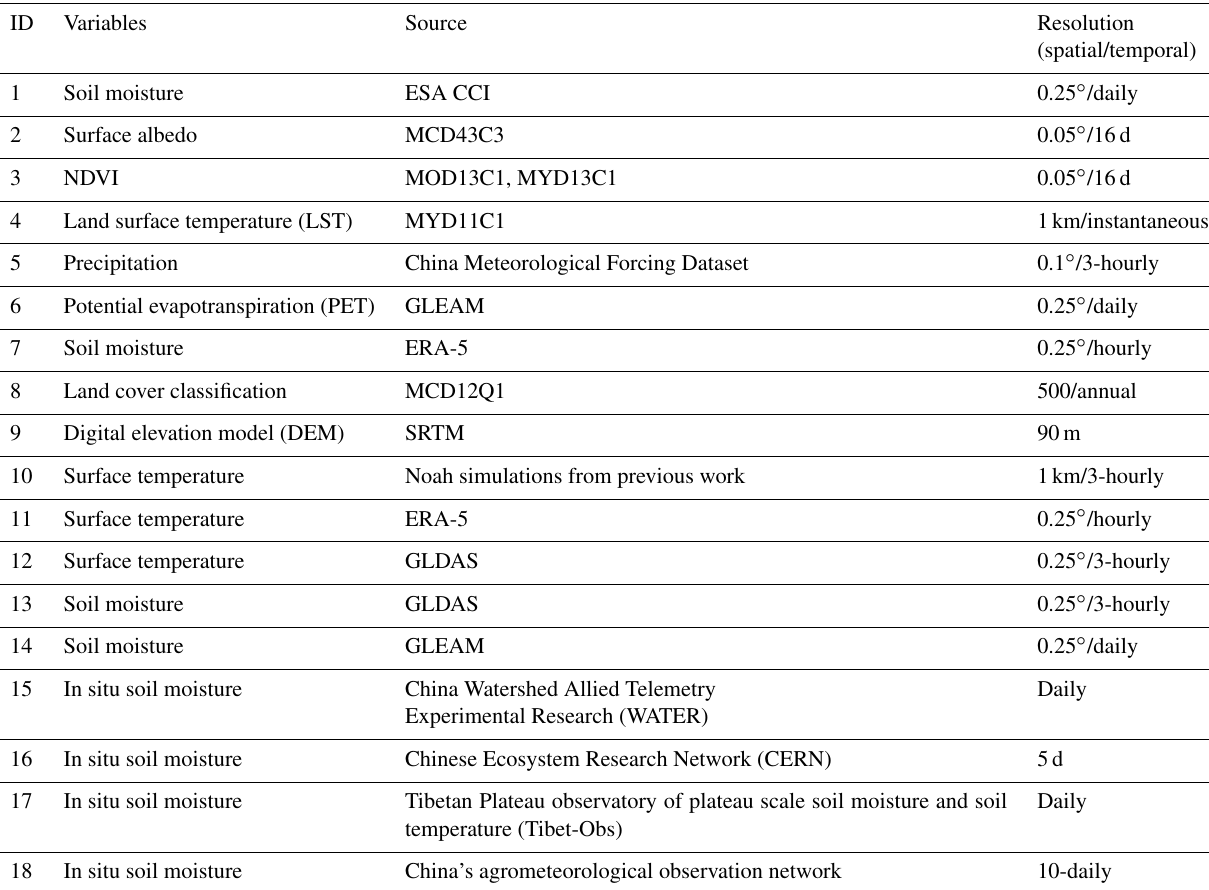
Table 1. Summary of the dataset used for the proposed model. The other dataset for the preliminary analysis but not the final utilization of the model is exhibited in Table S1 in the